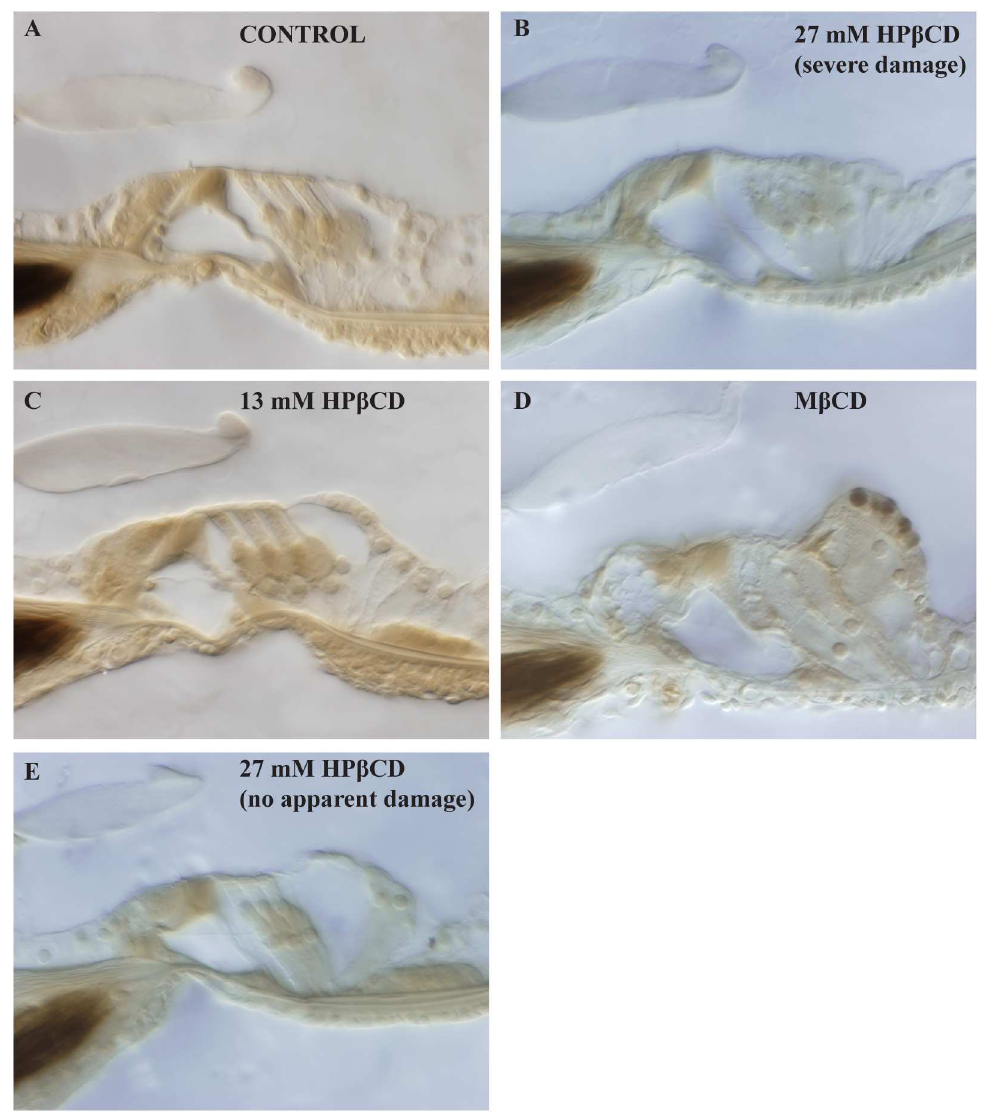
Fig 6. Histologyof second cochlear turn organ of Corti from exemplarears after apical injectionof artificial perilymph(control, Panel A), 13 mM HP β CD(Panel B), 27 mM HP β CD (PanelsC & D), and M β CD (Panel E). Histological assessment was not performed on ears receivingsalicylatetreatment. OHCs appearednormal in control ears and those receiving13 mM HP β CD.Ears receiving27 mM HP β CDhad a variety to appearances, from normal to severe damage.All ears treated with M β CDhad severe